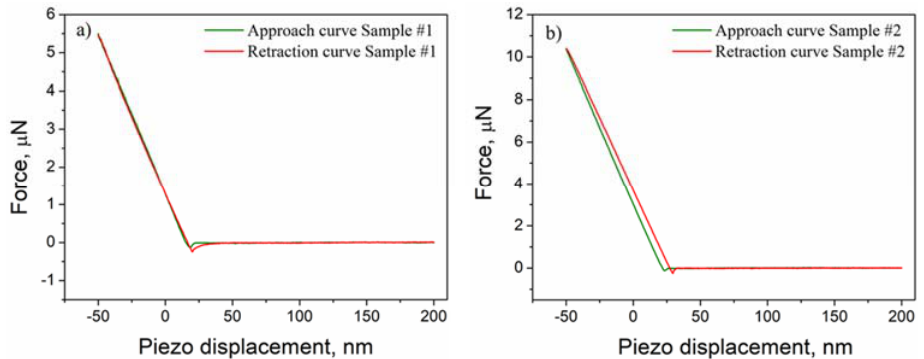
Figure 4. Force–distance curves measured during approach (green line) and retract (red line) on Sample #1 ( a ) and on Sample #2 ( b ).